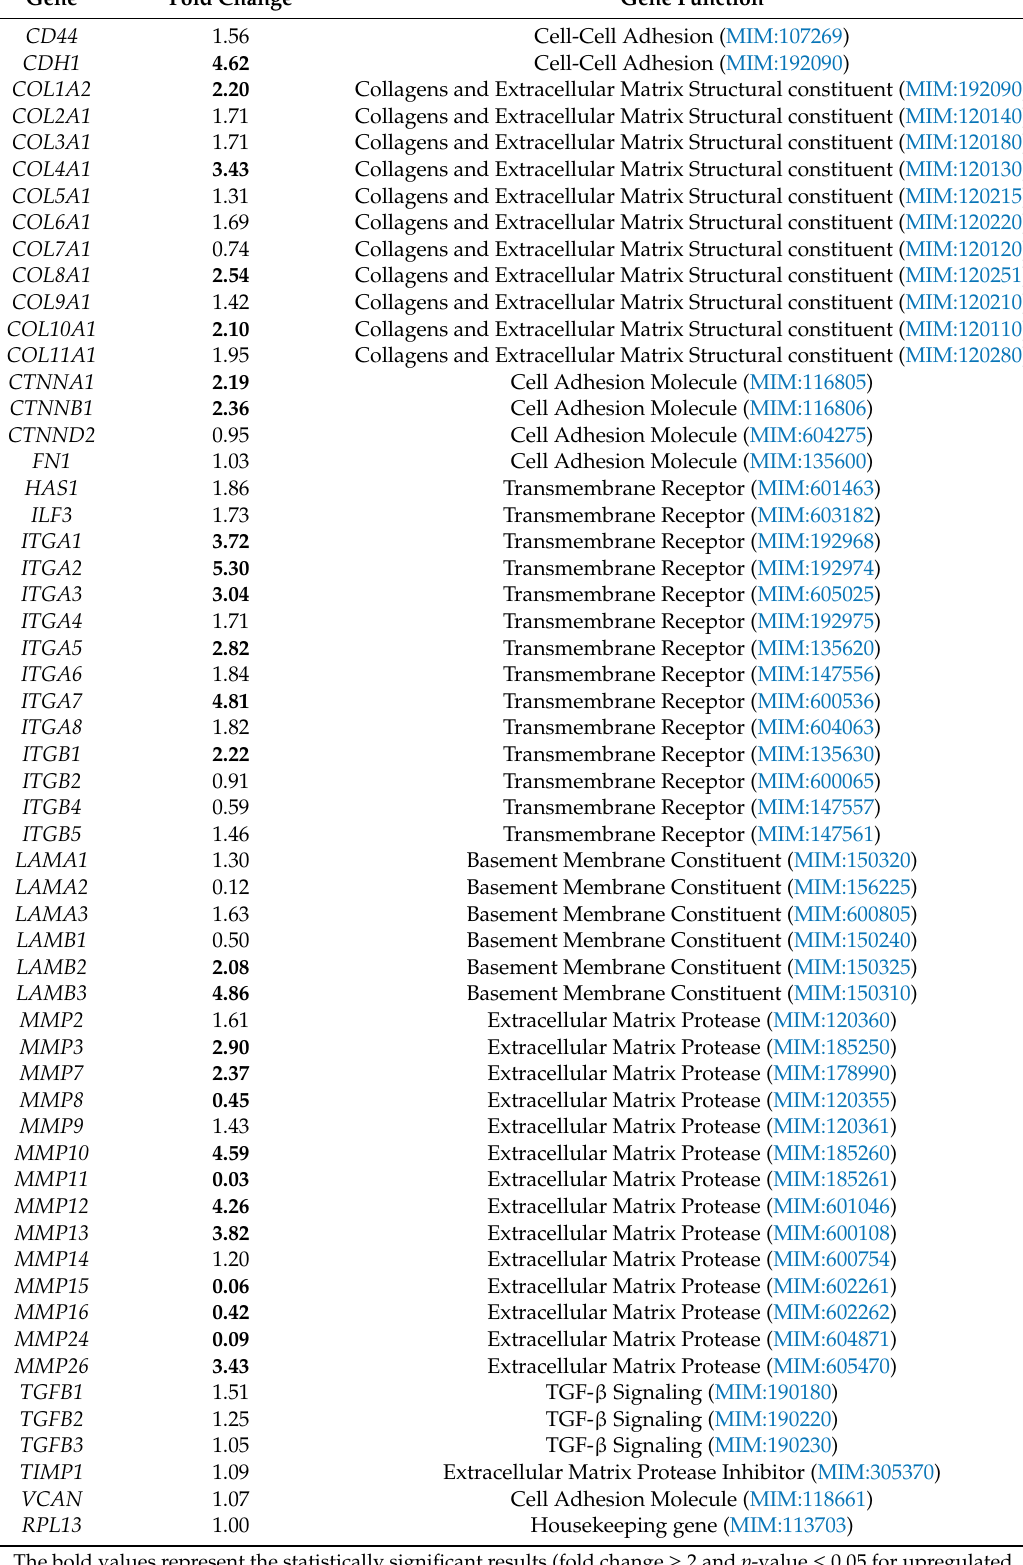
Table 1. Gene expression profile of 57 genes belonging to the “Extracellular Matrix and Adhesion Molecules” pathway analyzed using real-time PCR after 24 h of treatment with mycophenolate.